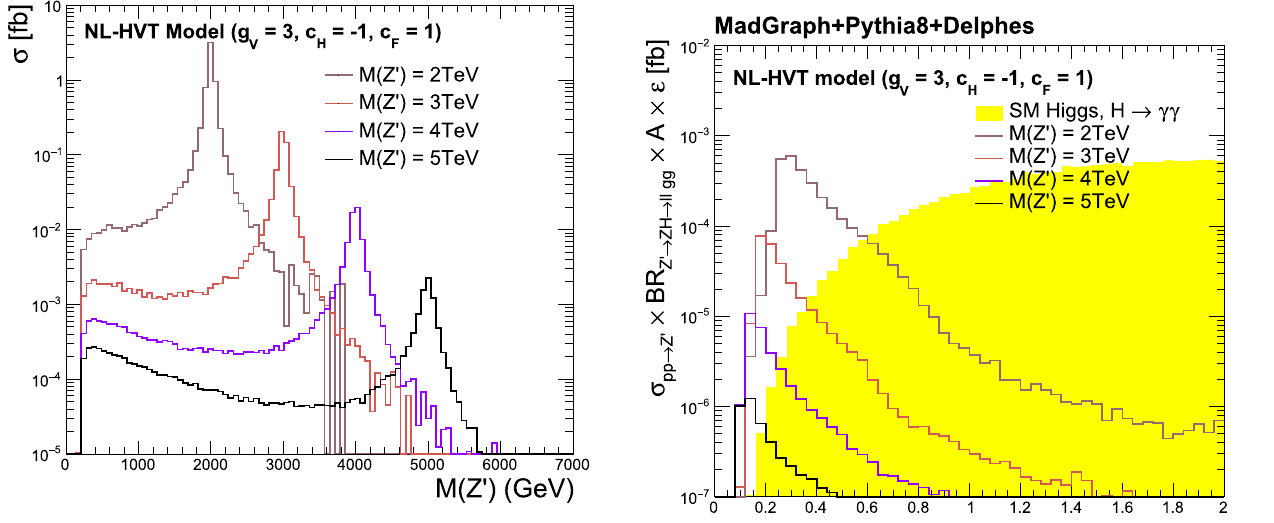
Fig. 4 Leading order Z (cid:2) resonance differential cross sections d σ/ dM ( Z (cid:2) ) as predicted from the HVT model modified by the non- local form factor of Eq. 3 with a = 1